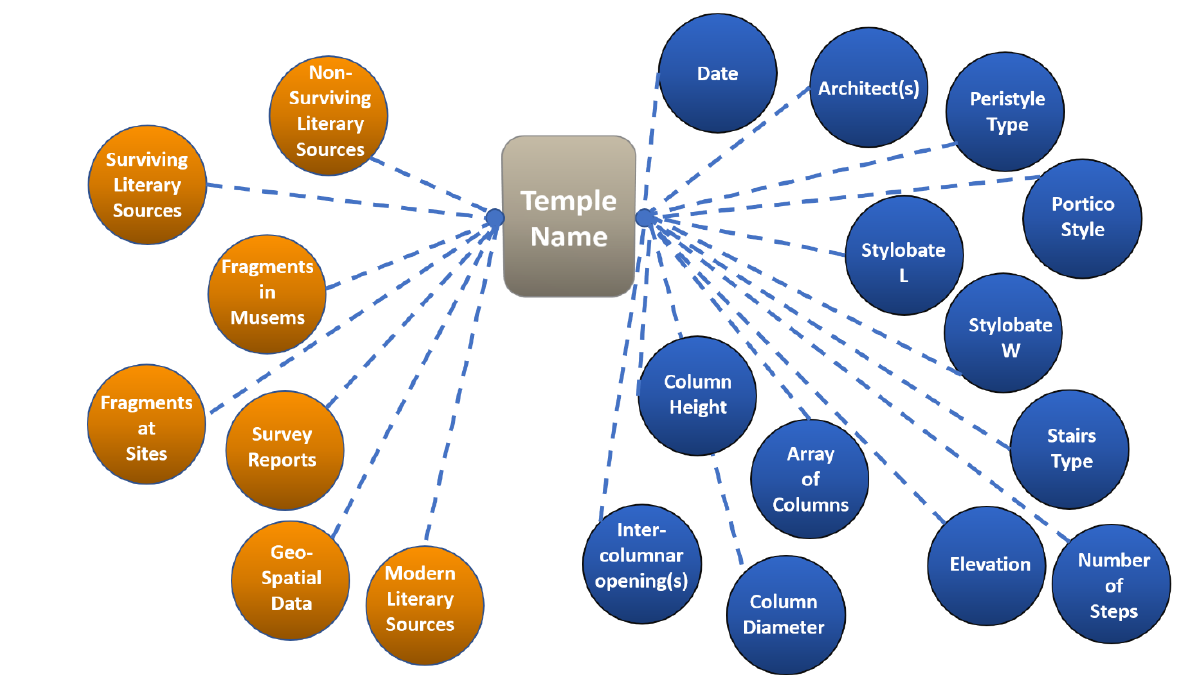
Figure 3. Curating the content: From compiled data to temple